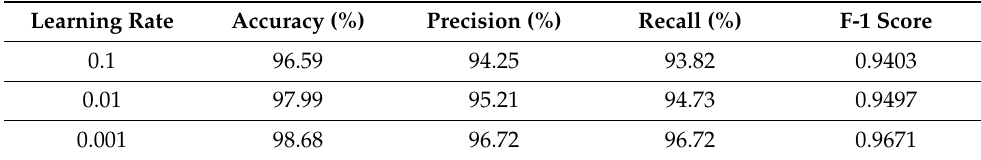
Table 10. Performance of the model with different learning rates.